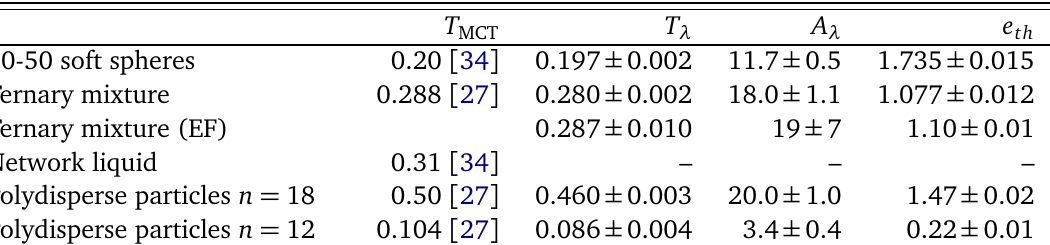
Table 1: Mode-coupling temperatures T fitting parameter A λ and threshold energies e for the network liquid no localization transition could be